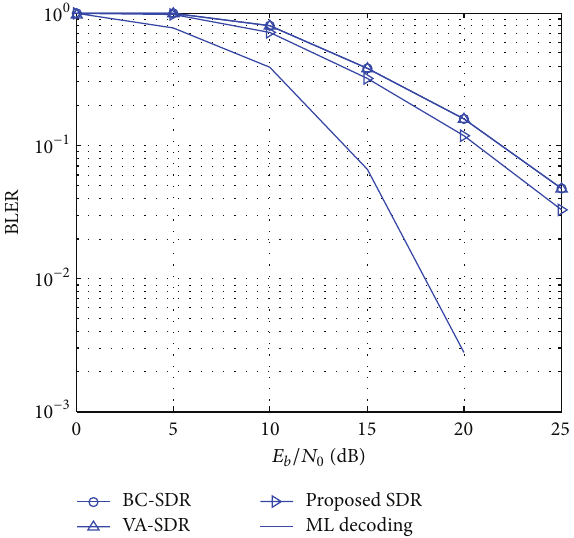
Figure 3: The computational time of the SDR detectors for 4 × 4 256-QAM MIMO systems.